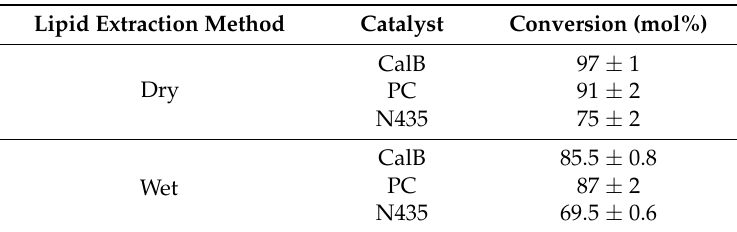
Table 4. Conversion to FAEEs using single lipases.